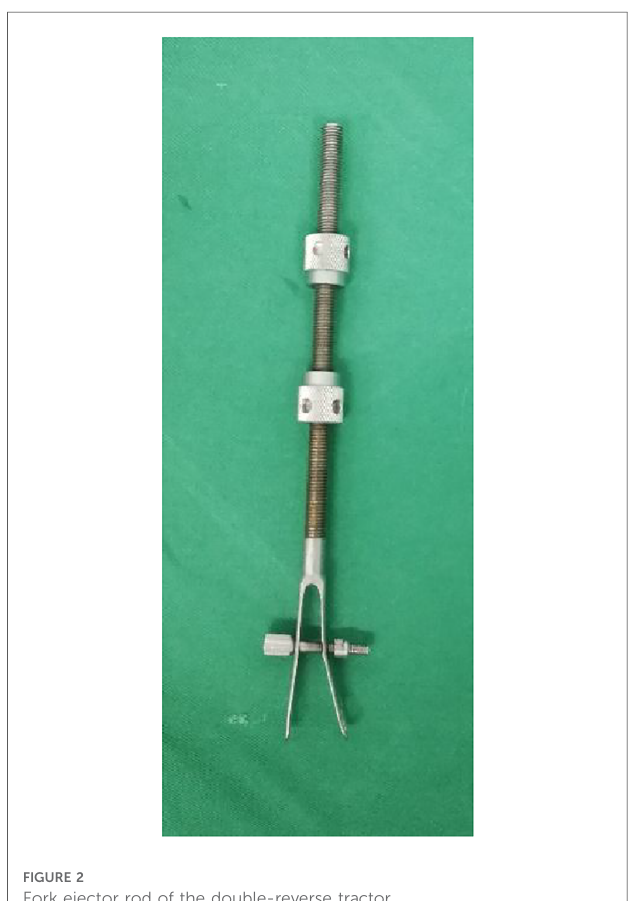
FIGURE 2 Fork ejector rod of the double-reverse tractor.